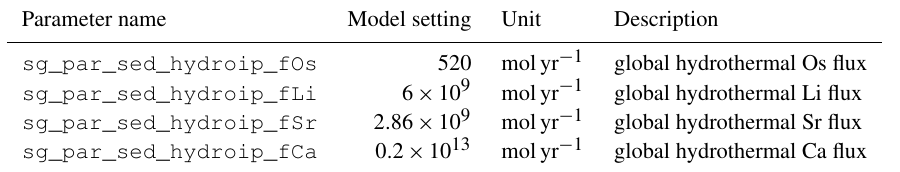
Table E2. Model parameters setting hydrothermal metal input.